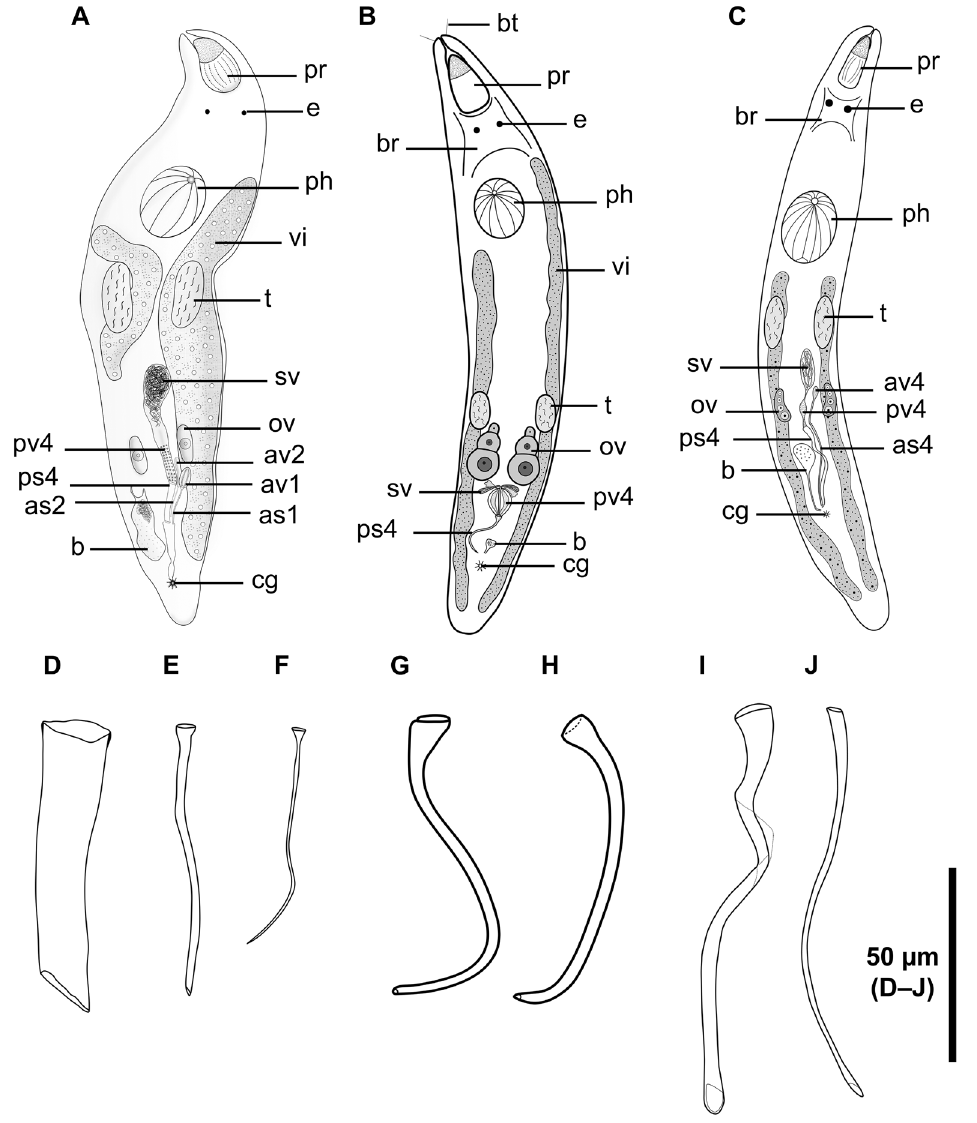
Fig. 1. New species of Phonorhynchoidinae Tessens, Janssen & Artois, 2014. A, D–F . Brachyrhynchoides ortizi sp. nov. A . Live animal. D . Prostatic stylet type IV. E . Accessory stylet I. F . Accessory stylet II. B, G–H . Djeziraia adriani sp. nov. B . Live animal. G–H . Prostatic stylet type IV. C, I–J . Phonorhynchoides lalanai sp. nov. C . Live animal. I . Prostatic stylet type IV. J . Accessory stylet type IV. D–G, I–J . From the holotypes (FMNH). H . Reference specimen